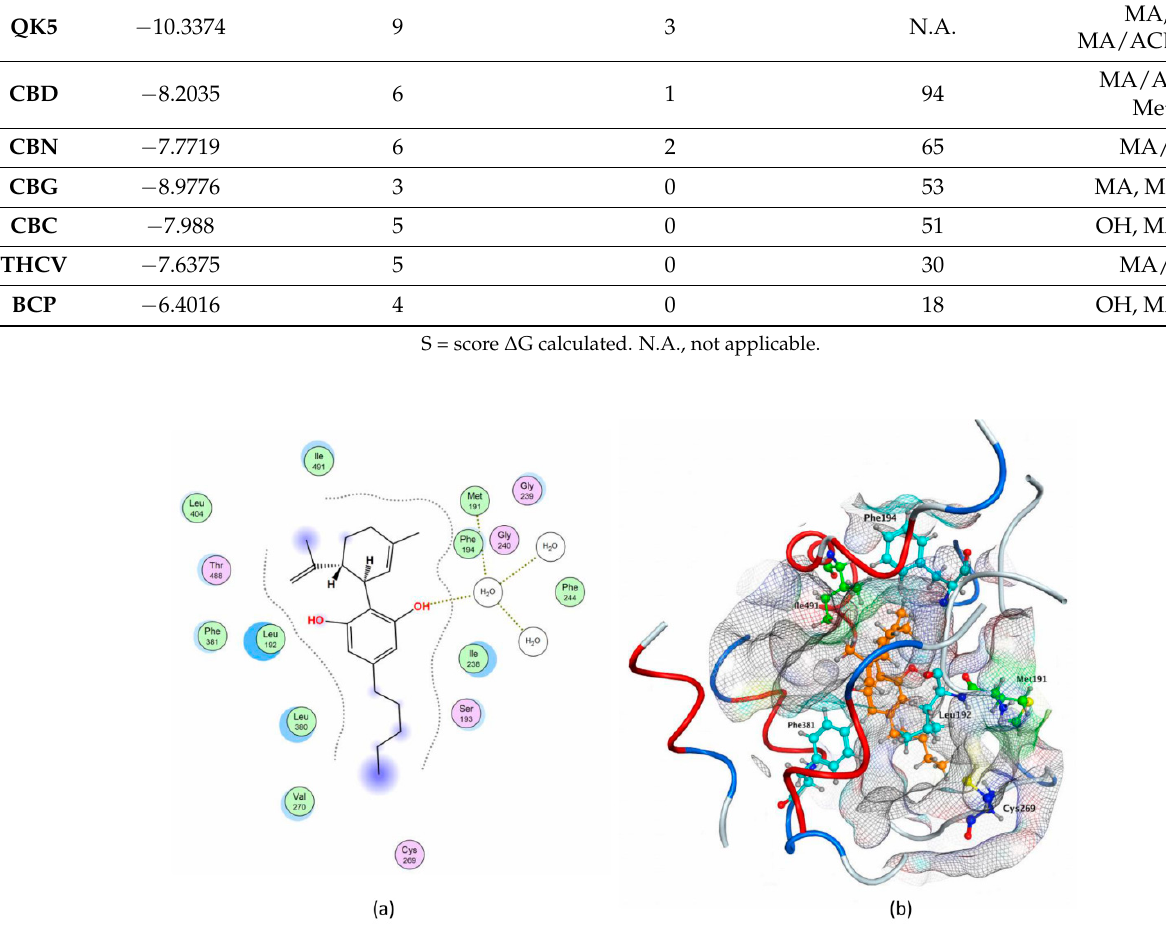
% In Vitro Inhibition Binding Cavities (At 100 µ m)